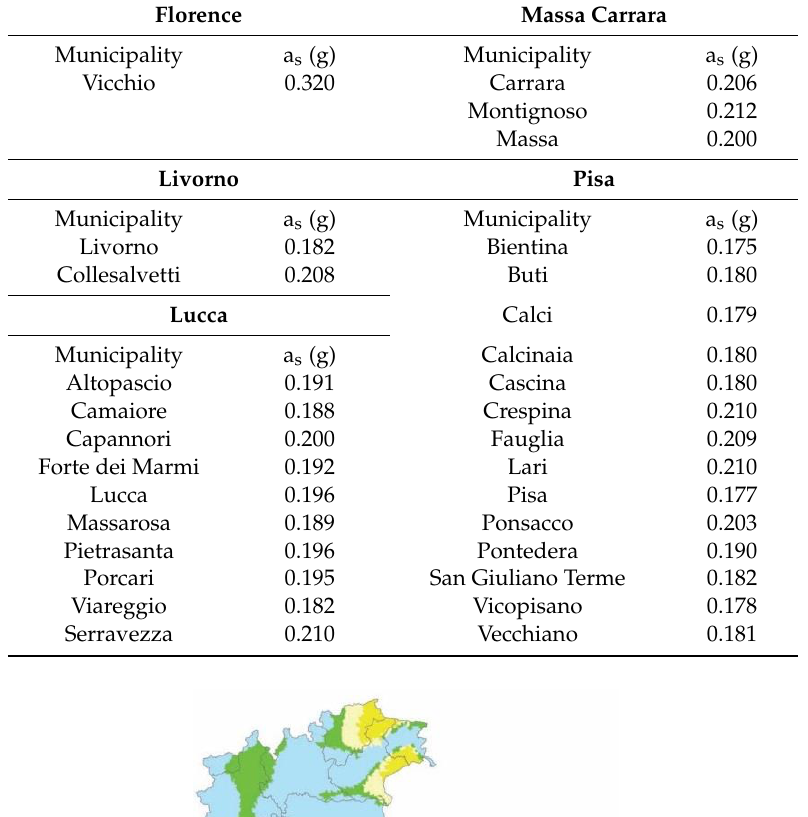
Table 4. Free-field peak ground acceleration (a s ) at each municipality, according to NTC (2018) [46].